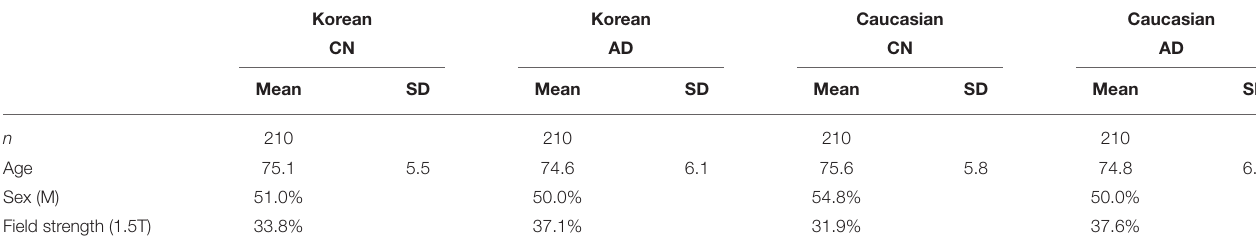
TABLE 4 | Sample sizes of normal people and AD patients of Koreans and Caucasians. Korean Korean Caucasian Caucasian